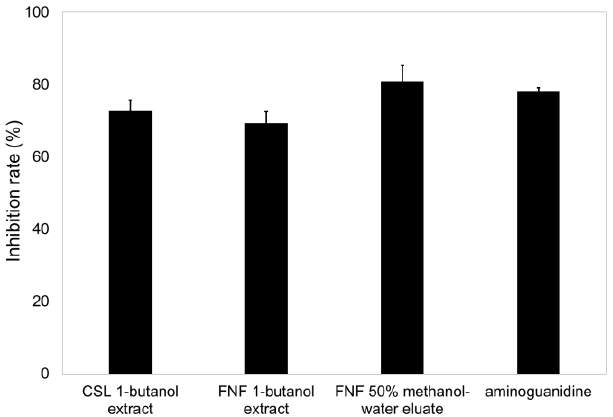
Figure 1. AGEs inhibitory activity of extracts. n = 3. Sample concentrations: 50 μg /mL. Aminoguan- idine: positive control; CSL: Coriander; FNF: Fennel.